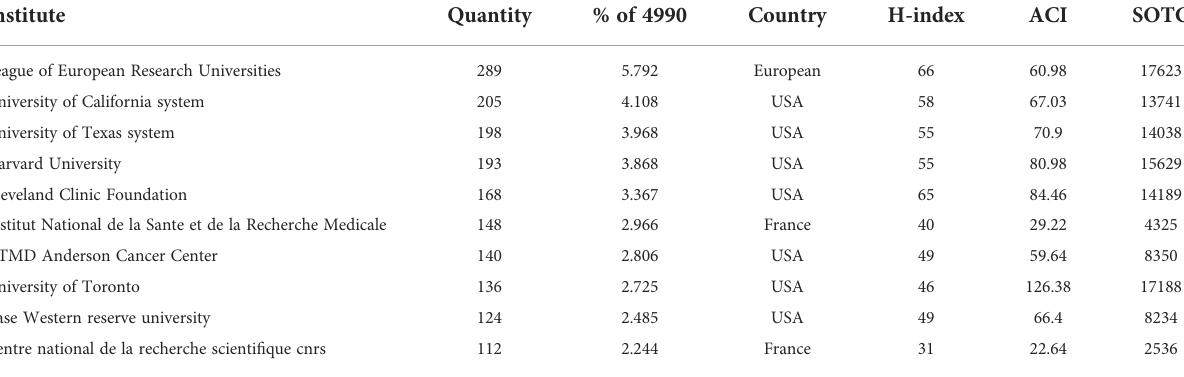
TABLE 2 The top 10 research institutions in regard to the research on glioma stem